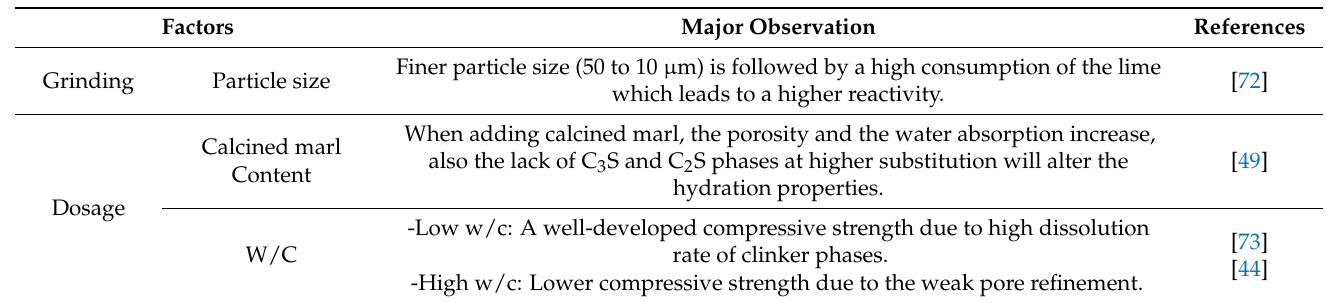
Table 3. Factors influencing the performance of calcine marl-based